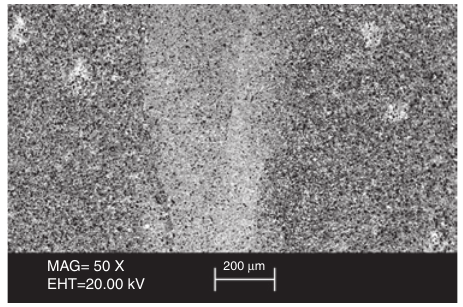
Figure 11 SEM microstructure image of the N6 sample.